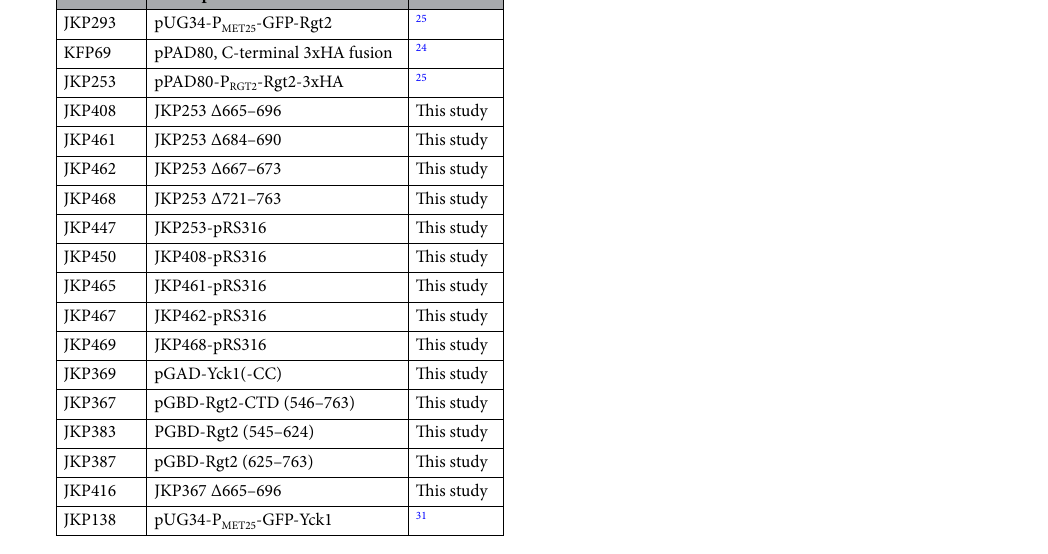
Table 2. Plasmids used in this